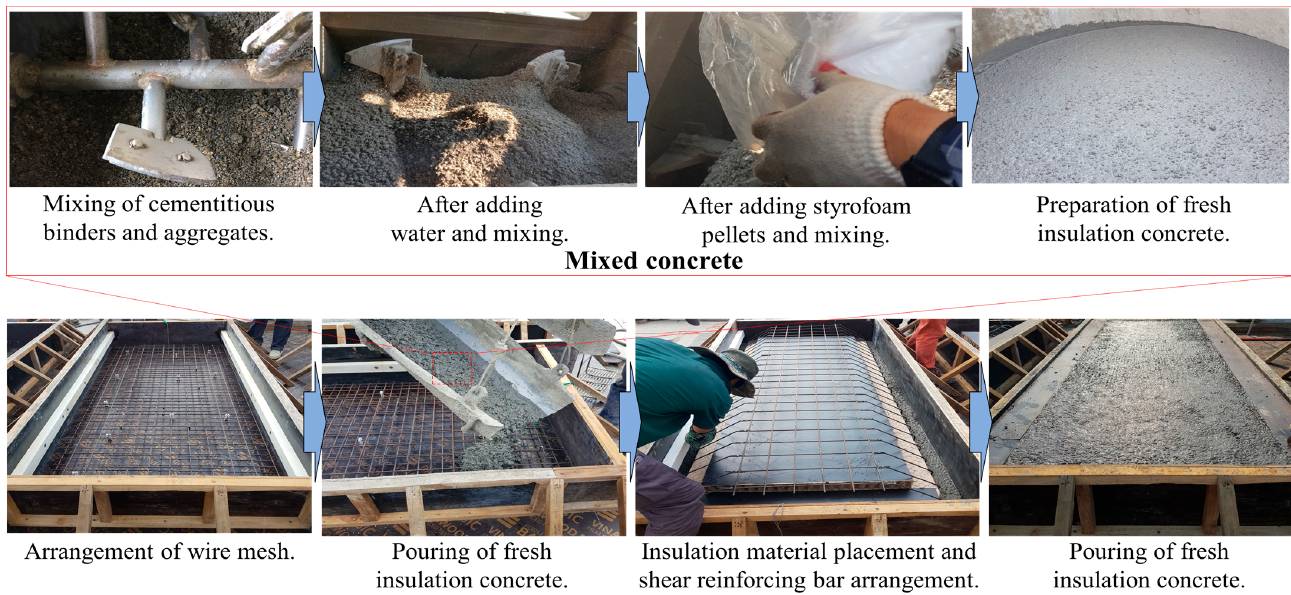
Figure 3. Details of the insulation-panel specimens (units: mm).